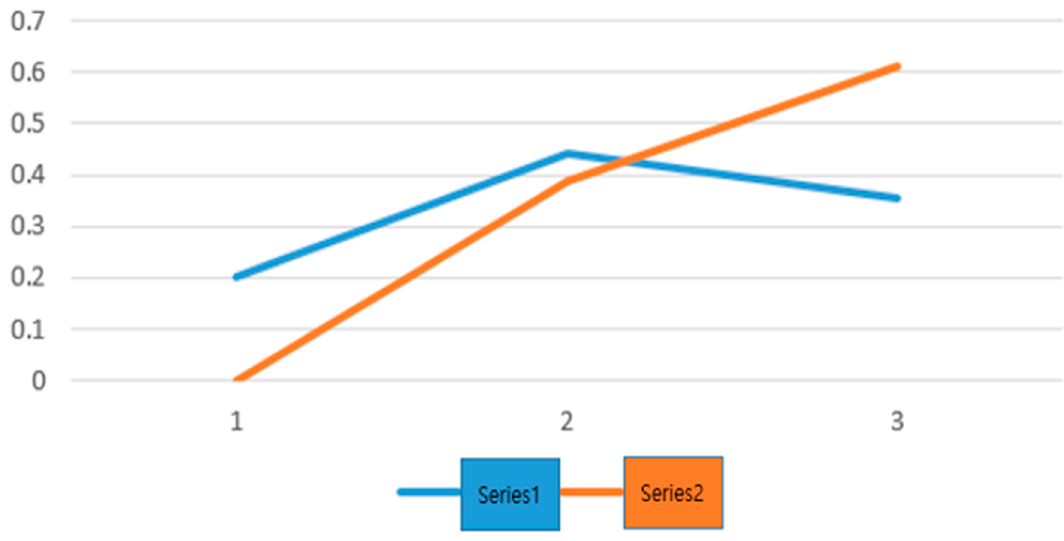
Figure 17. Comparison between the appearance frequency of “mosquito” and maximum power (“Living Culture” section of Naver news, 2016).